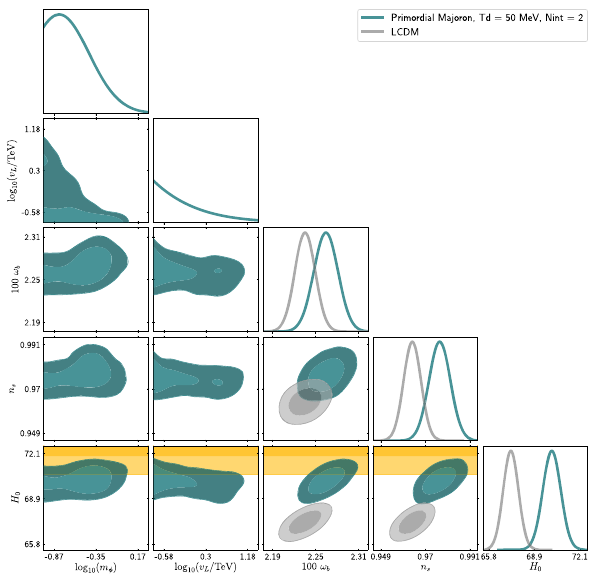
Fig. 6 MCMC fit to Planck2018+BAO data for a majoron cosmology with N int = 2 (green) with T d = 50 MeV, and for (cid:3) CDM (grey). One and two sigma posteriors on H 0 from the SH 0 ES collaboration are presented in yellow